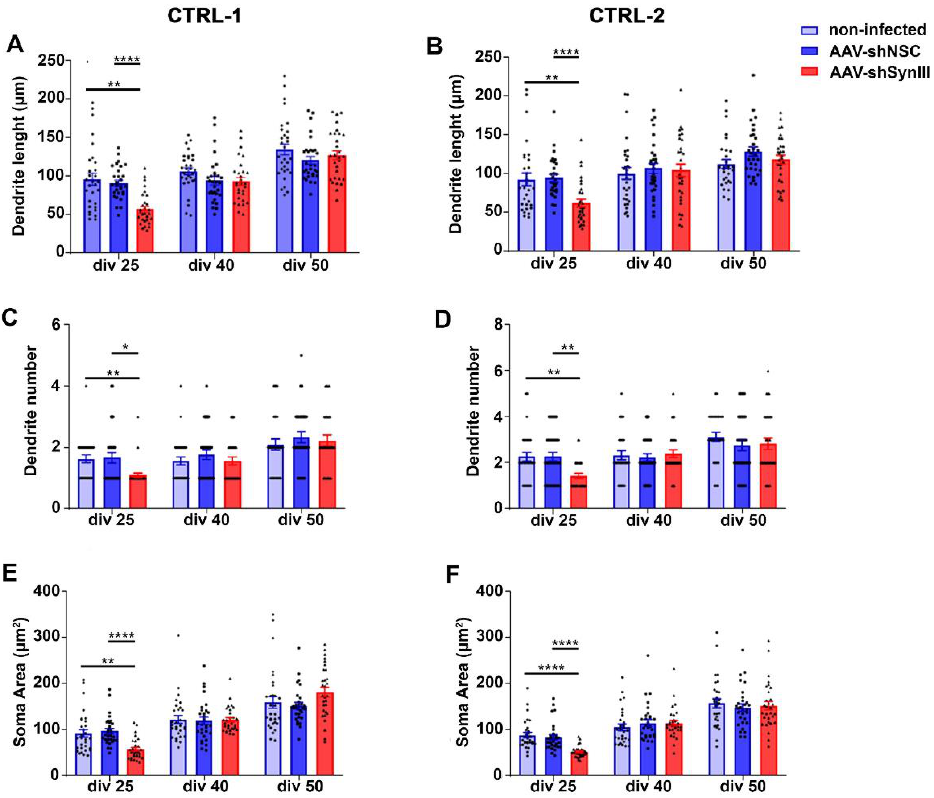
Figure 7. AAV-mediated Syn III RNAi impaired early iPSCs-derived mDN development. ( A , B ) Graphs show primary dendrite length analysis (expressed in µm) in control non-infected AAV- shSynIII- or AAV-shNSC-infected mDN produced from CTRL-1 ( A ) and CTRL-2 ( B ) iPSCs clones